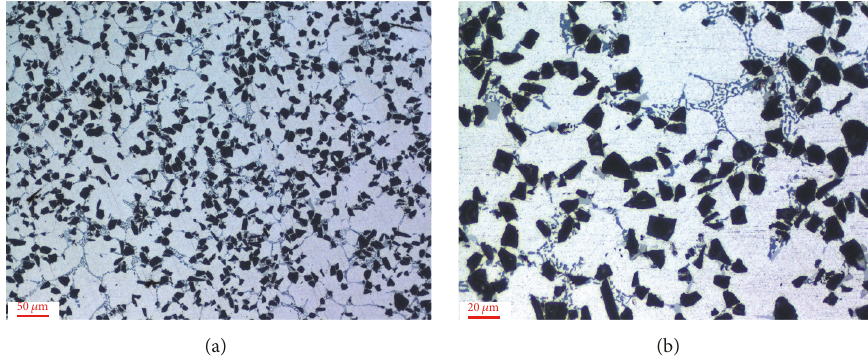
Figure 1: Microstructure of SiCp/A356 composites: (a) 200x and (b) 500x.